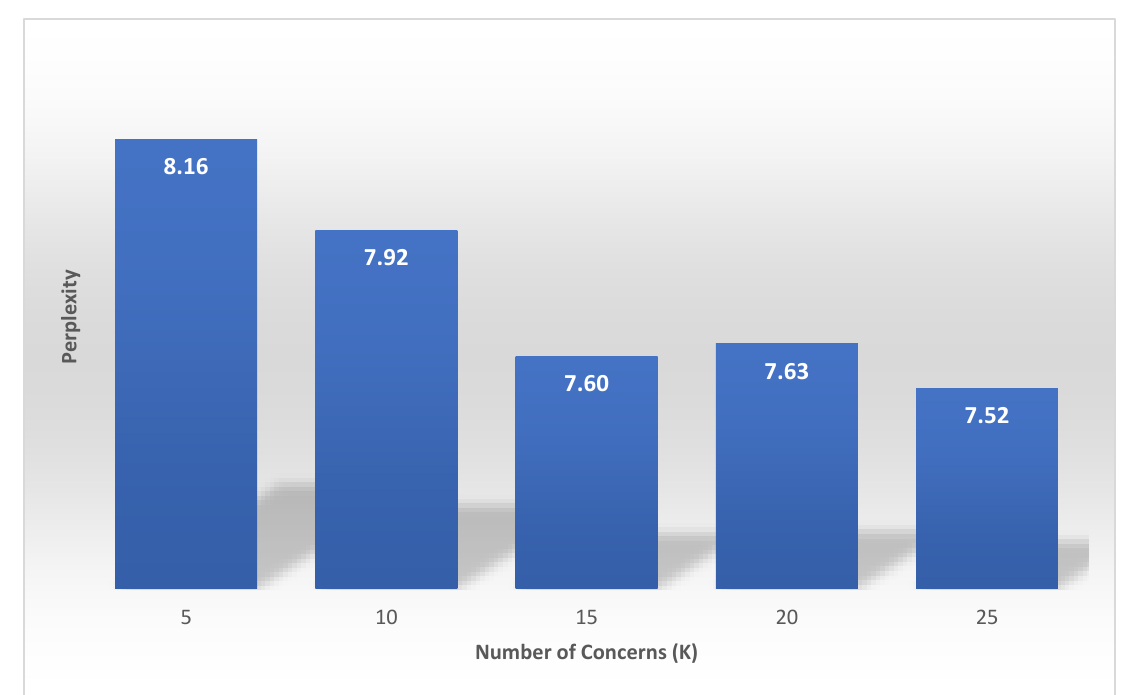
Figure 3. Perplexity score versus the number of concerns.